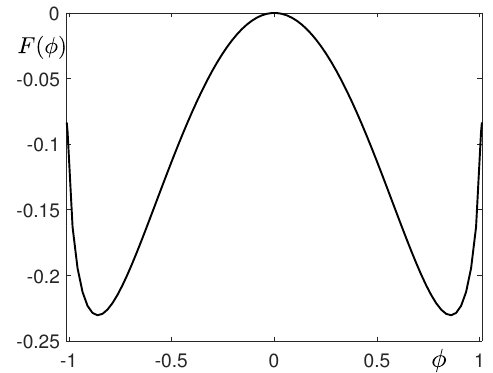
Figure 21. Logarithmic Flory–Huggins free energy with θ e = 1 and θ c =